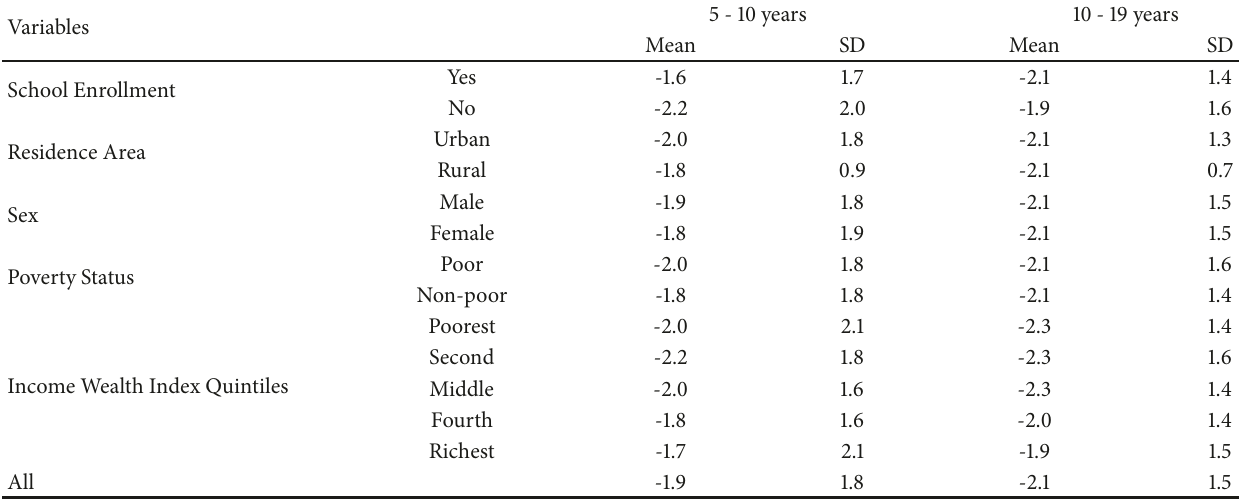
Table 2: The means and standard deviations (SD) of HAZ according to age groups.